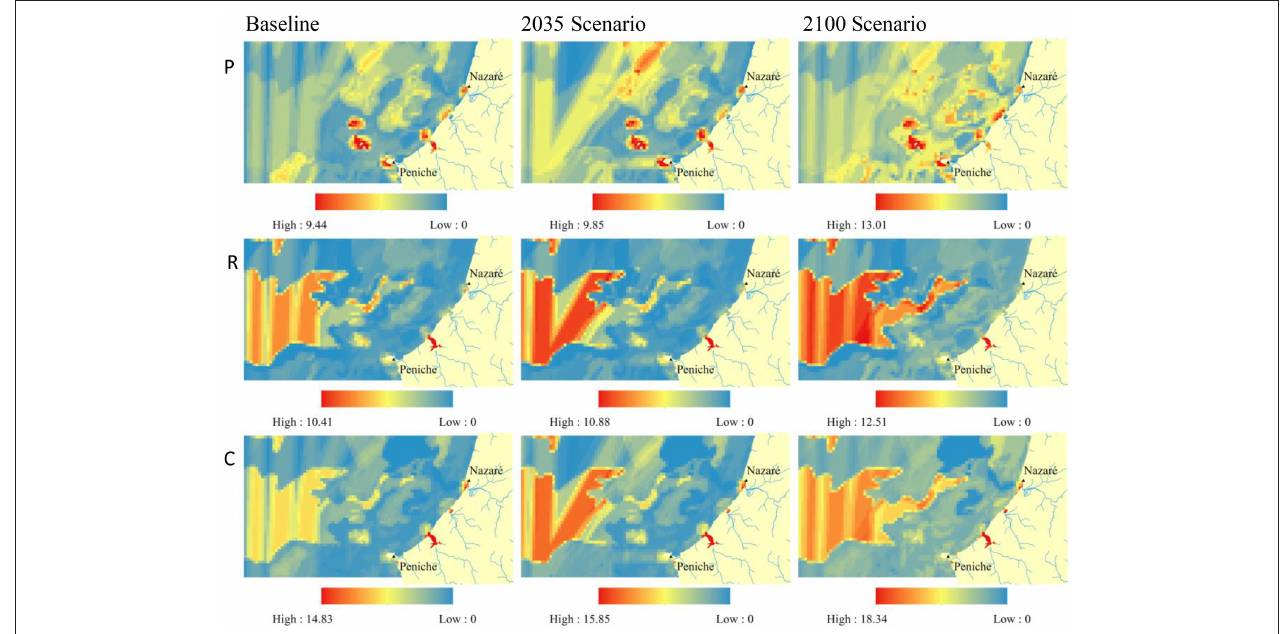
FIGURE 6 | Marine ES vulnerability maps for the complex Atlantic region between Peniche and Nazaré for the present condition (baseline) and for the years 2035 and 2100 prospective scenarios: Provisioning (P) , Regulating and Maintenance (R) , and Cultural (C)